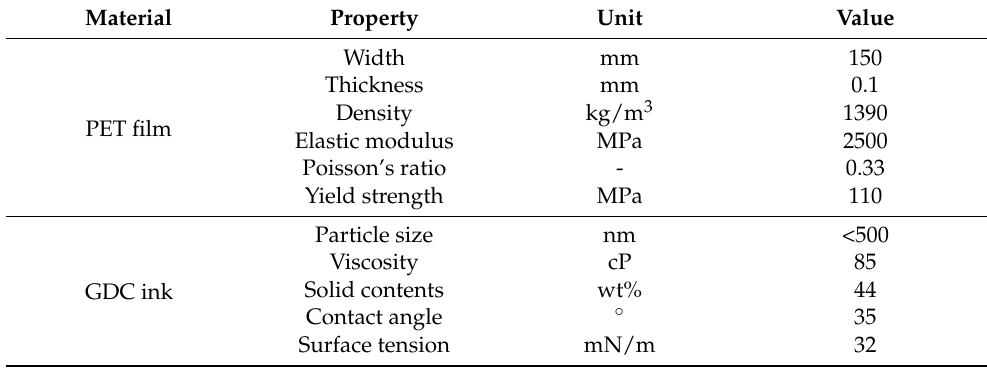
Figure 3. ( a ) Gadolinium-doped ceria coating layer; ( b ) the force-sensing resistor at the rewinding section; and ( c ) wound coated layer aging procedure. Table 1. Properties of the PET film, gadolinium-doped ceria (GDC) ink, and GDC-coated layer.